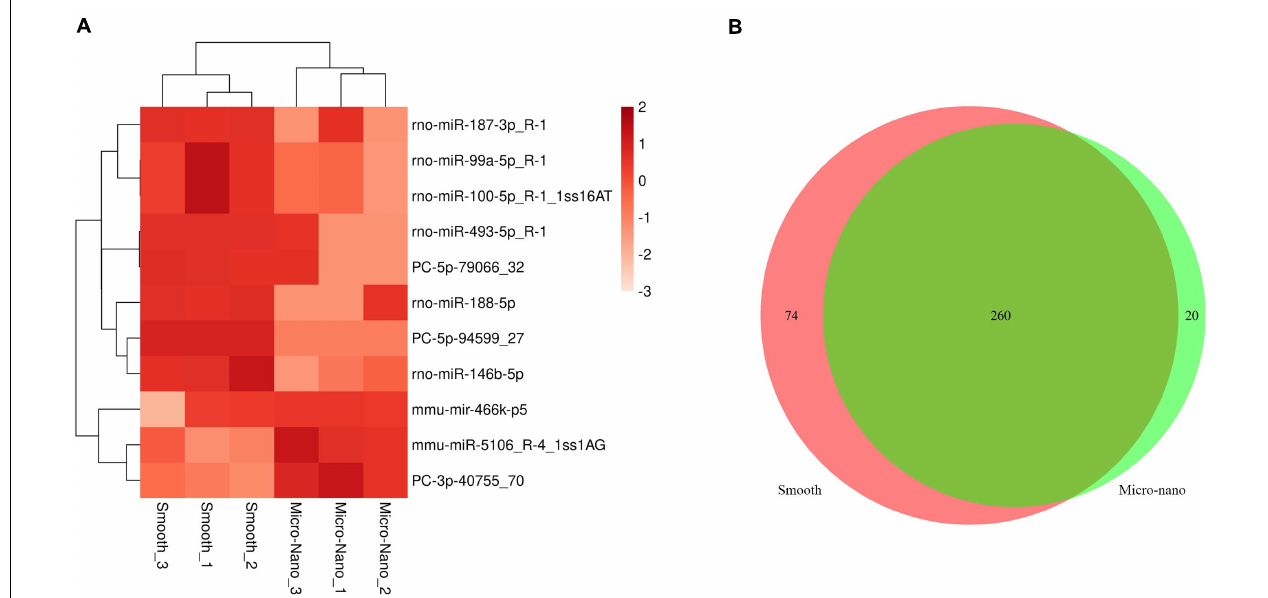
FIGURE 4 | Differentially expressed microRNAs were detected in RAW264.7 cell-derived exosomes stimulated by smooth and small-scale topography titanium disks. (A) The heat map of differentially expressed exosome miRNAs; (B) Venn map showed that there were 260 common miRNAs and 20 specific miRNAs in the differentially expressed